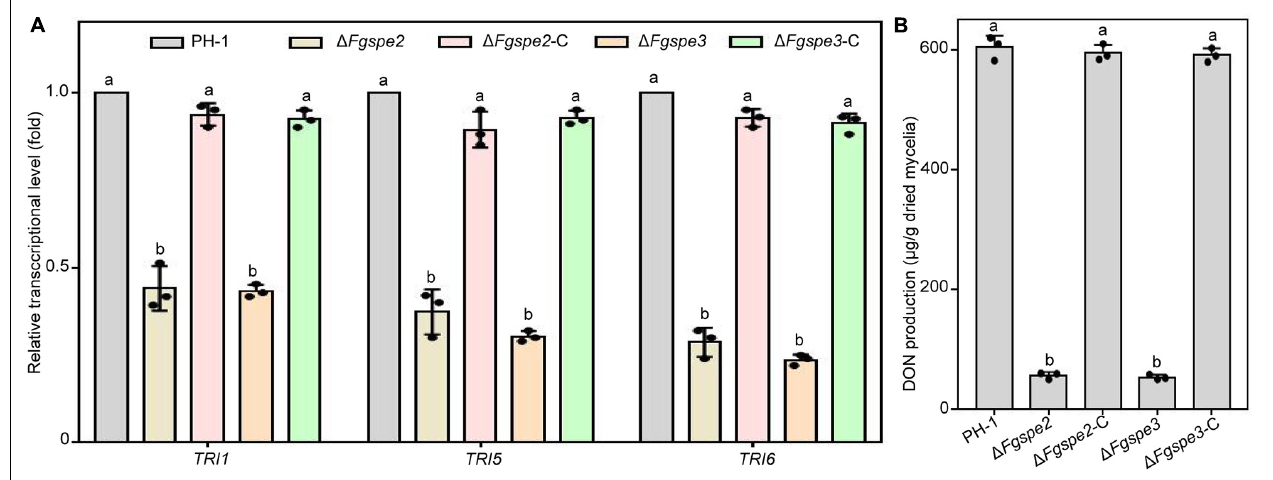
FIGURE 8 | Effects of (cid:49) Fgspe2 and (cid:49) Fgspe3 mutants on DON biosynthesis. (A) Relative expression levels of TRI1 , TRI5 , and TRI6 in the wild-type PH-1 and (cid:49) Fgspe3 in TBI medium for 2 days. The ACTIN gene was served as an internal control. (B) DON contents of the wild-type PH-1 and (cid:49) Fgspe3 strains after in TBI medium 7 days of incubation. Columns listed with the same letter are not significantly different at P =